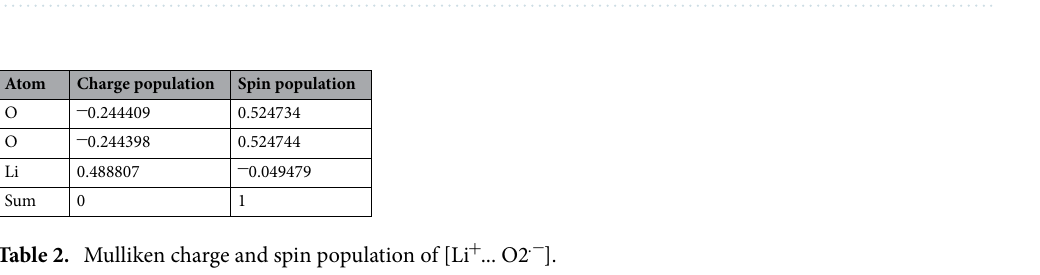
Table 2. Mulliken charge and spin population of [Li + ... O2